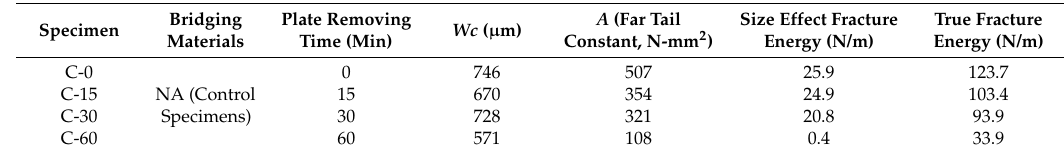
Figure 13. Elapsed time versus decremented fraction of fracture energy: ( a ) true fracture energy ( G F ); and ( b ) size effect fracture energy ( G f ).